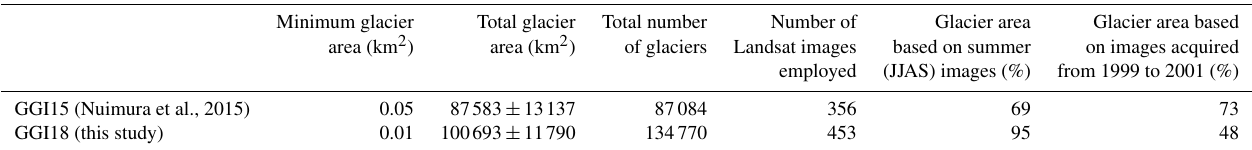
Table 1. Comparison of the GGI15 and GGI18 inventories in terms of the total glacier area, glacier area ratio based on summer imagery, and based on imagery acquired between 1999 and 2001. Minimum glacier Total glacier Total number Number of Glacier area Glacier area based area (km 2 ) area (km 2 ) of glaciers Landsat images based on summer on images acquired employed (JJAS) images (%) from 1999 to 2001 (%) GGI15 (Nuimura et al., 2015) 0.05 87583 ± 13137 87084